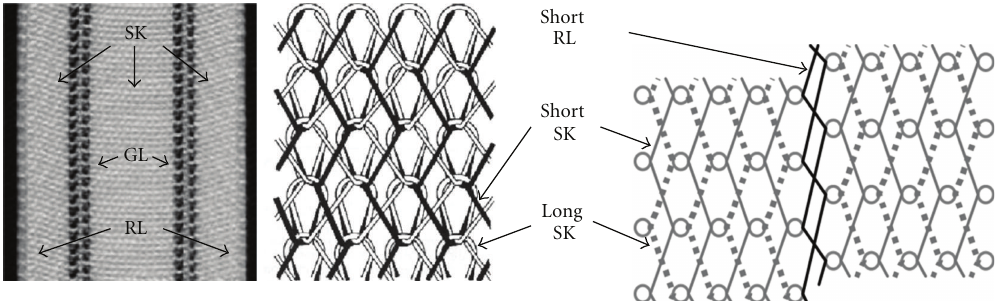
Figure 4: Schematic characterization of the textile structure of the virgin Cooley Double Velour prosthesis and of the virgin Microvel Double Velours prosthesis; (RL: remeshing line; SK: standard Knit, GL:Guide Line).